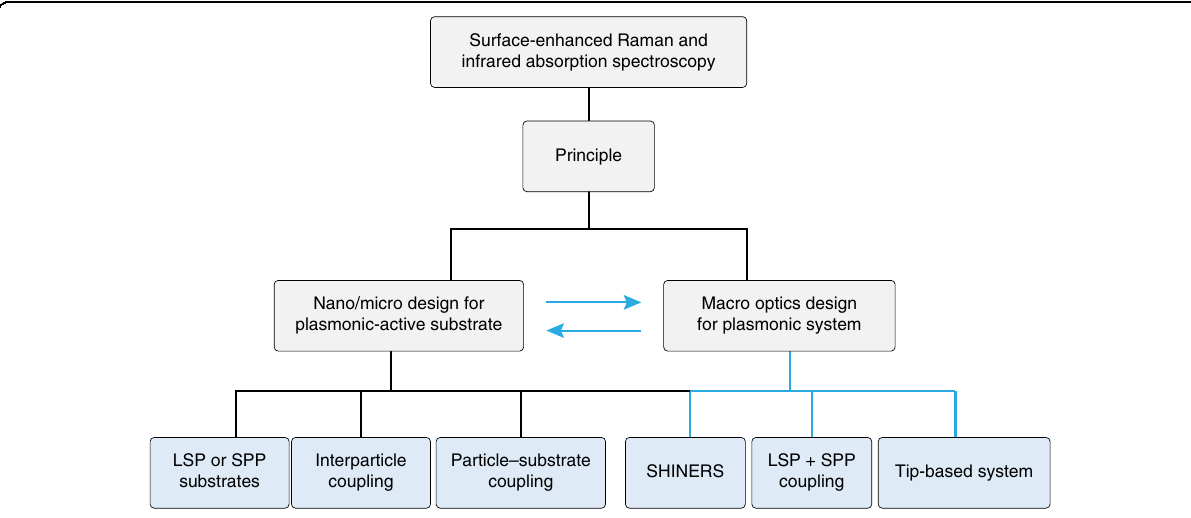
Fig. 2 Optical design from nano/micro substrates to macro-optics for SERS and SEIRA. Nano/micro designs are the key elements of SERS and SEIRA, which determines the sensitivity of SERS and SEIRA. Macro-optical designs depend on the features of nano/micro structured